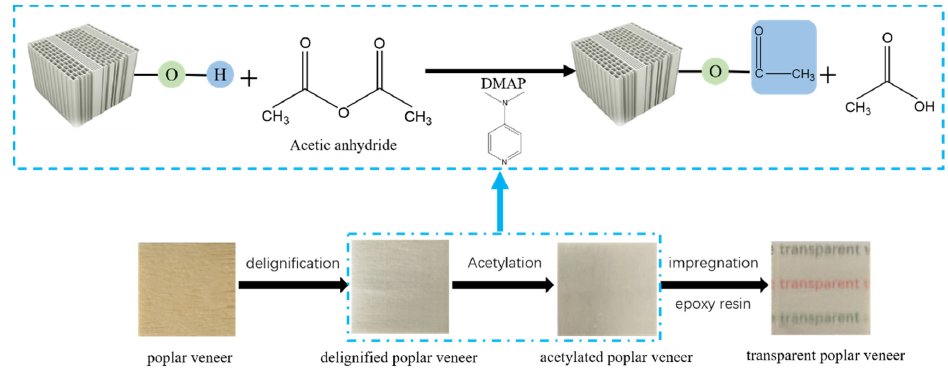
Figure 1. Scheme of the preparation process of transparent poplar veneers by acetylation modifica- tion.